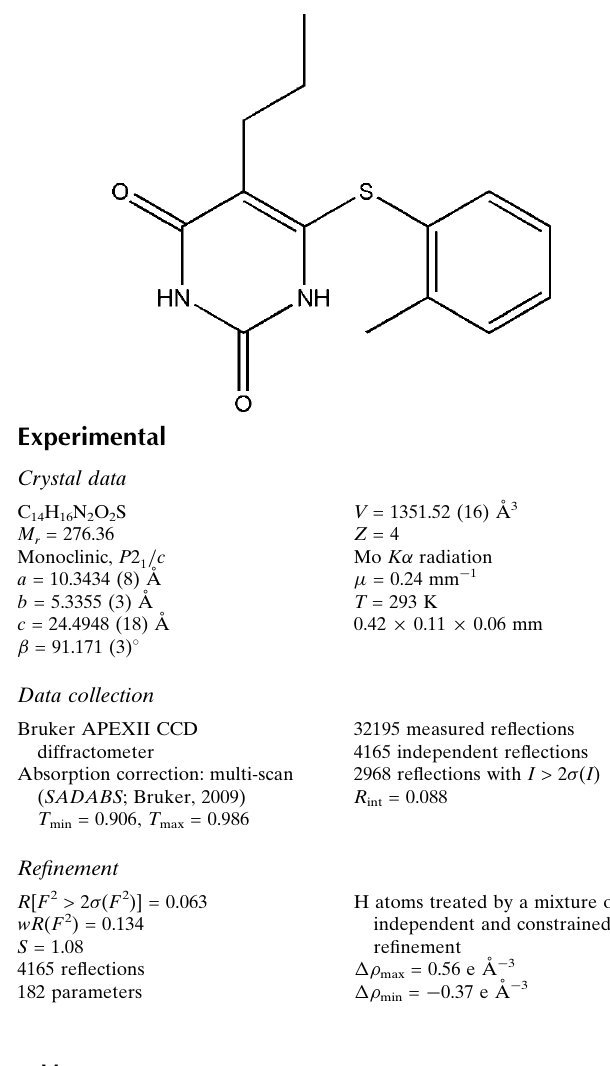
Data collection Bruker APEXII CCD diffractometer